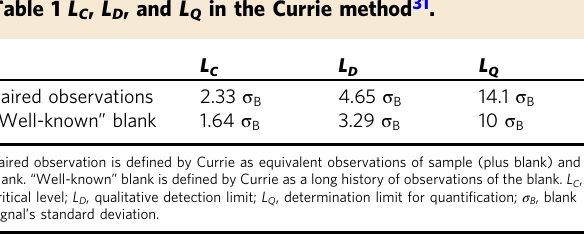
Table 1 L C , L D , and L Q in the Currie method 31